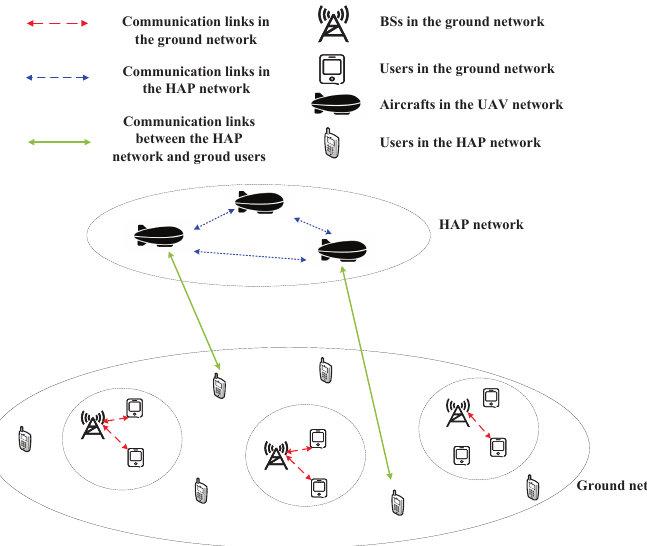
Figure 3. Spectrum sharing between HAP networks and ground